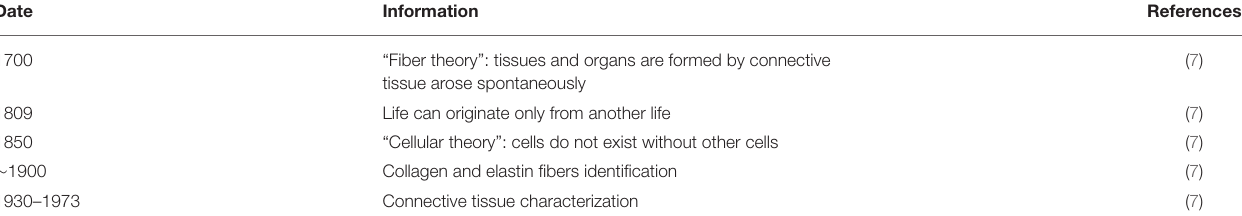
TABLE 1 | Timeline of our understanding of the extracellular matrix (ECM).